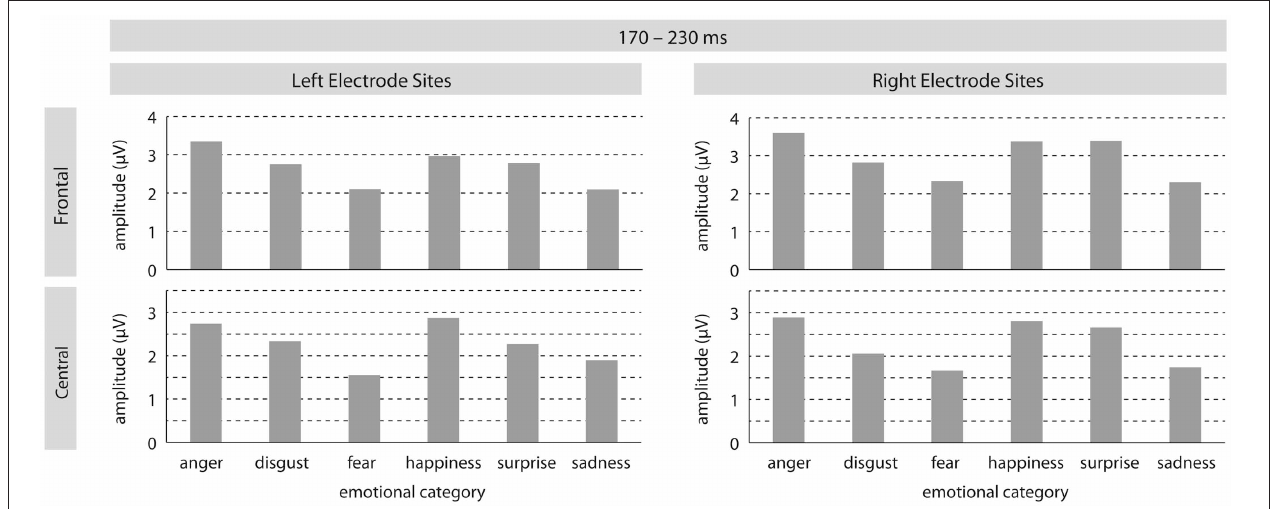
FIGURE 1 | The illustration shows mean P200 amplitudes(inmV) for each emotional category at left/right frontal and left/right central electrode-sites.